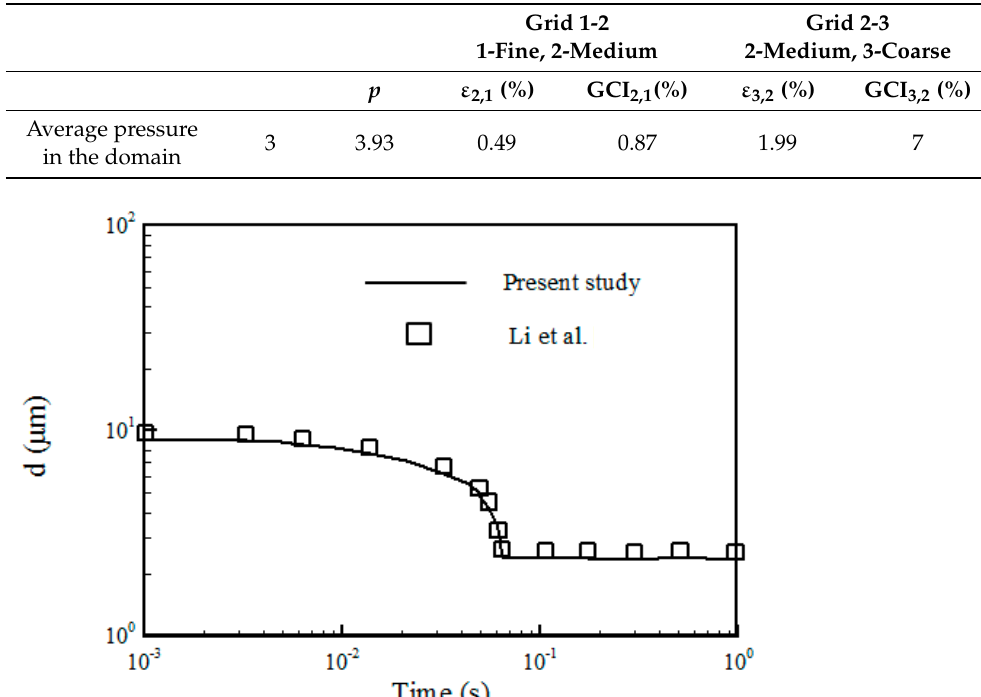
Figure 5. Validation of the present computational results for an evaporating 10 μ m droplet by com- parison with the data from [3].